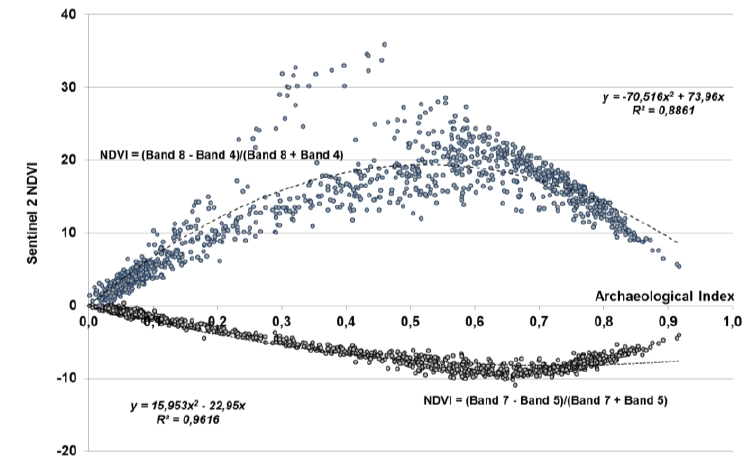
Figure 6. Best fit 2nd polynomial order of the Sentinel-2 NDVI compared to the Normalized Archaeological Index. NDVI was calculated using Bands 4 and 8, and Bands 5 and